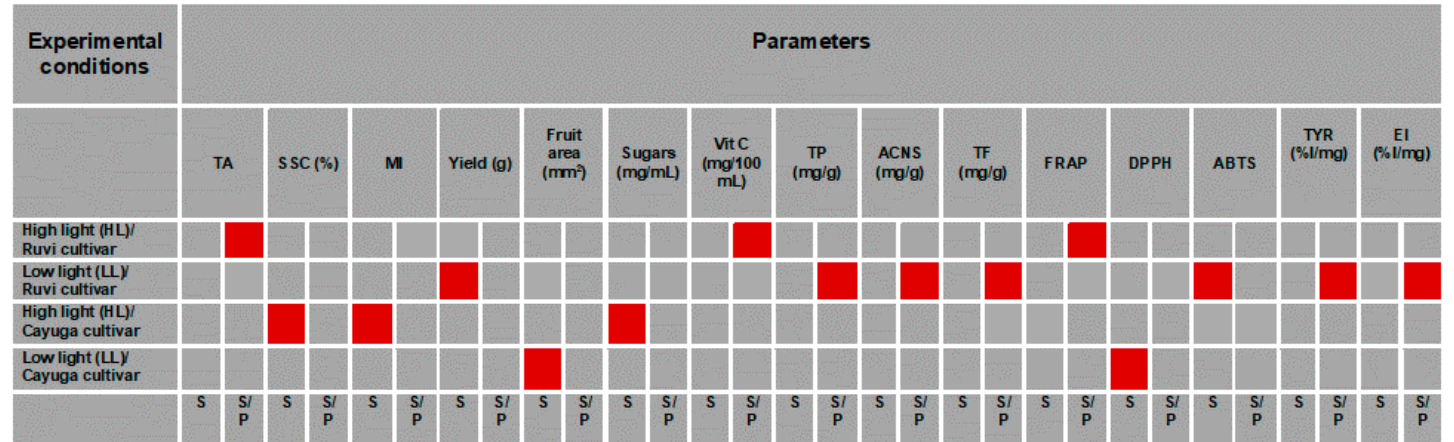
Figure 7. Summary of the key experimental results. Red colored cells represent the conditions with the highest measured value. Abbreviations: ABTS: 2,2 ′ -azino-bis-3-ethylbenzthiazoline-6-sulphonic acid free radical scavenging method; ACNS: Anthocyanins; DPPH: α , α -diphenyl- β -picrylhydrazyl free radical scavenging method; El: Elastase; FRAP: ferric reducing ability of plasma; % I: % Inhibition; MI: maturity index (ratio of total soluble solids/titratable acidity, SSC/TA); S: Soil; P: Soil/peat mixture; SSC: soluble solids concentration; TA: titratable acidity; TP: Total phenolics; TF: Total flavonoids; TYR: tyrosinase.